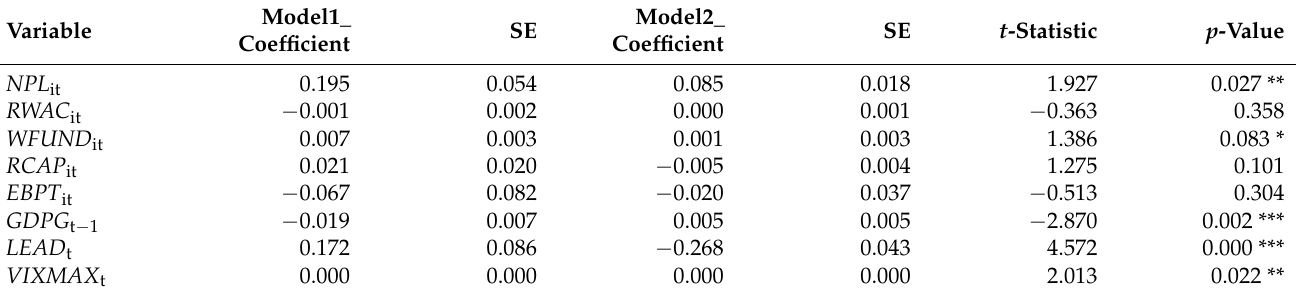
Table A6. Comparison of crisis (3) and post-crisis